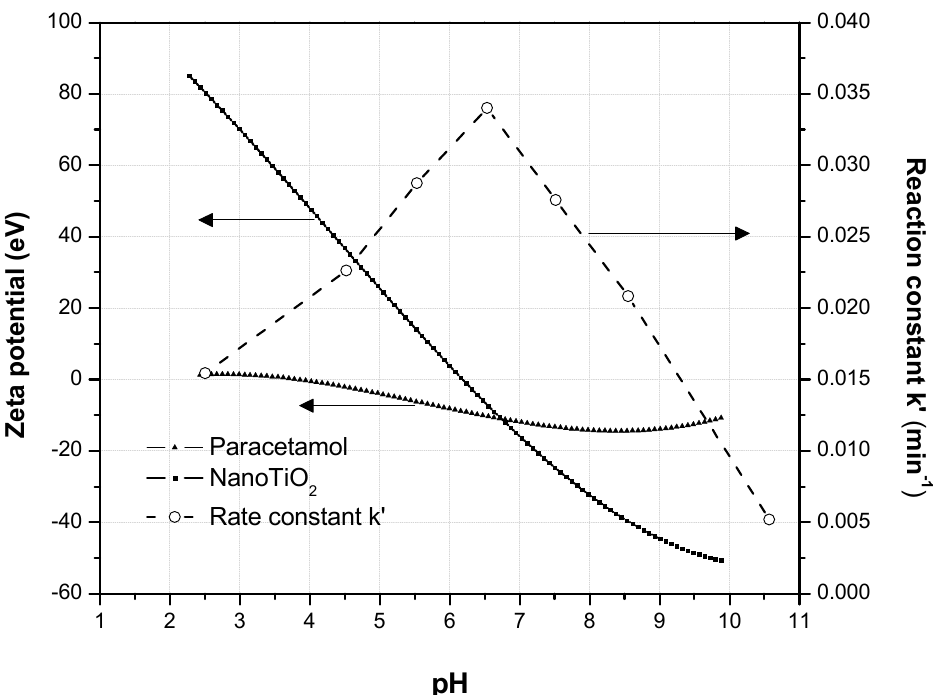
Figure 4. Graph of the zeta potential of the substrate and the photocatalyst with the variation of pH. This result is consistent with the Langmuir-Hinshelwood kinetic model because it suggests that the adsorption-desorption equilibrium between the surface of the semiconductor and the fluid phase is indispensable for initiating the photodegradation of any substrate. Once this equilibrium